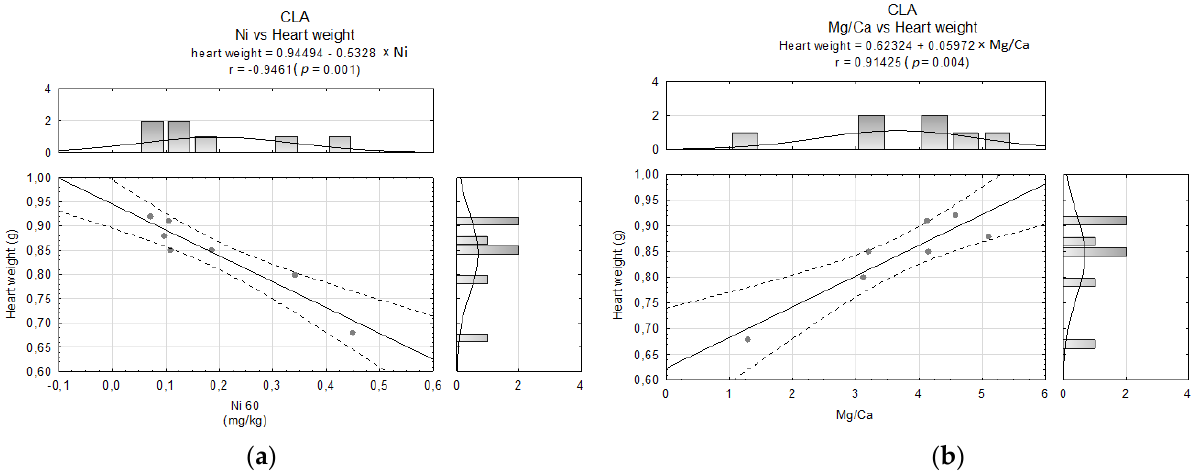
Figure 5. Correlations between ( a ) Ni content and heart weight and ( b ) Mg/Ca ratio and heart weight in the CLA group.